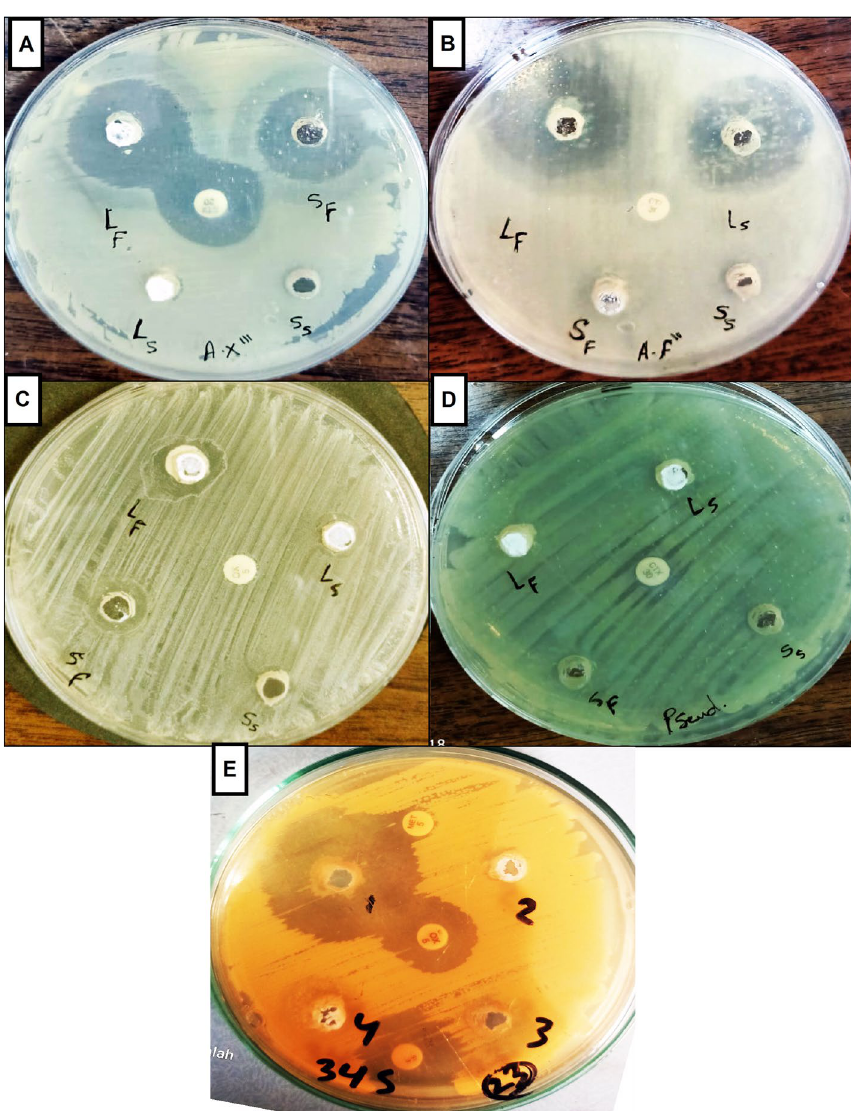
Figure 2. Inhibition zone showing the antibacterial activity of fresh fig latex on bacteria isolated from diabetic wounds. Causing a clear zone with diameter against the pathogenic bacteria ( A ) Paenibacillus sp., ( B ) Bacillus sp., ( C ) Pseudomonas sp. MS2, ( D ) Pseudomonas sp. MS4 and ( E ) Staphylococcus haemolyticus AUMC b-331 .